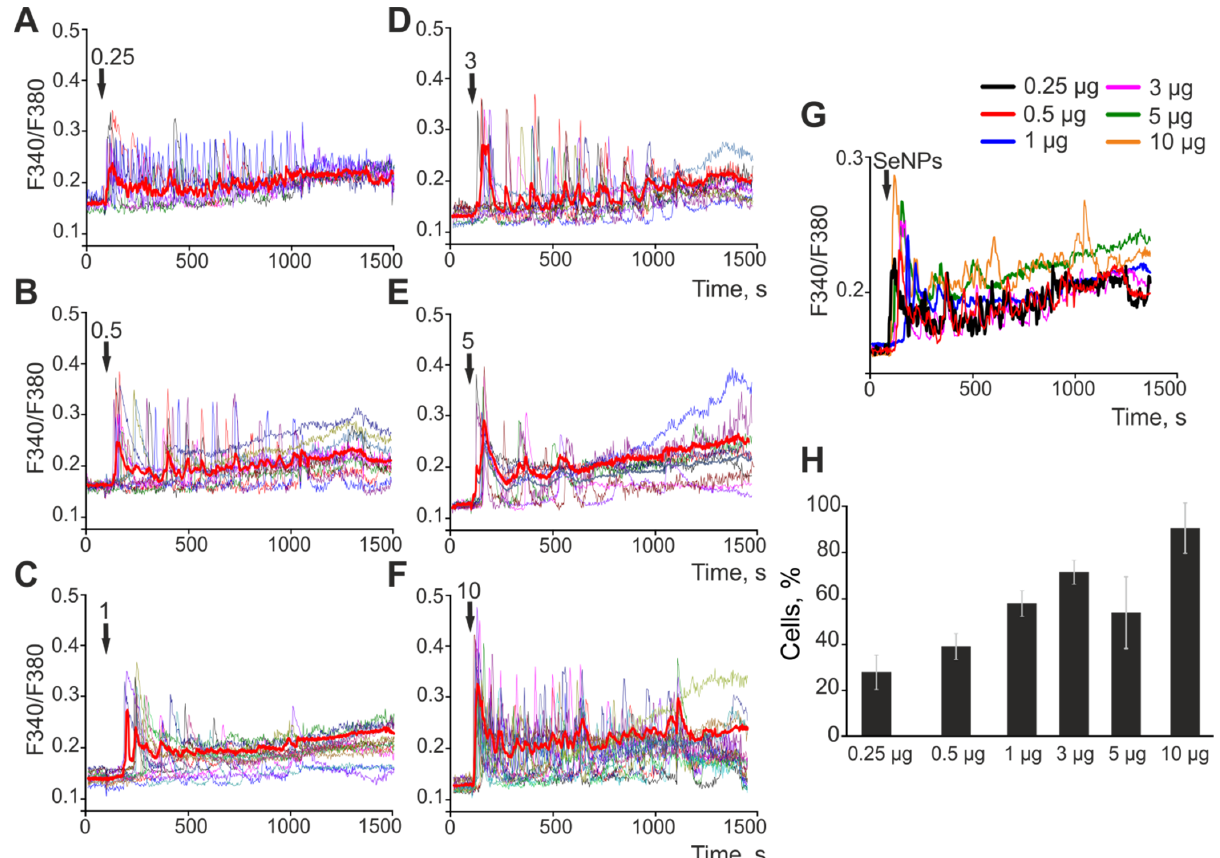
Figure 3. Application of various concentrations of 400 nm-sized SeNPs induces the generation of Ca 2+ signals in astrocytes of the cerebral cortex. ( A – F )—Ca 2+ signals of individual astrocytes in one experiment and their average value (red curve) for the application of increasing concentrations of SeNPs. ( G )—Astrocytic Ca 2+ signals averaged over several tens of cells for the application of in- creasing concentrations of 400 nm-sized SeNPs. ( H )—The percentage of astrocytes that respond with Ca 2+ signals to the application of SeNPs. The arrow indicates the moment of SeNPs application and their concentration in micrograms per mL ( μ g/mL).